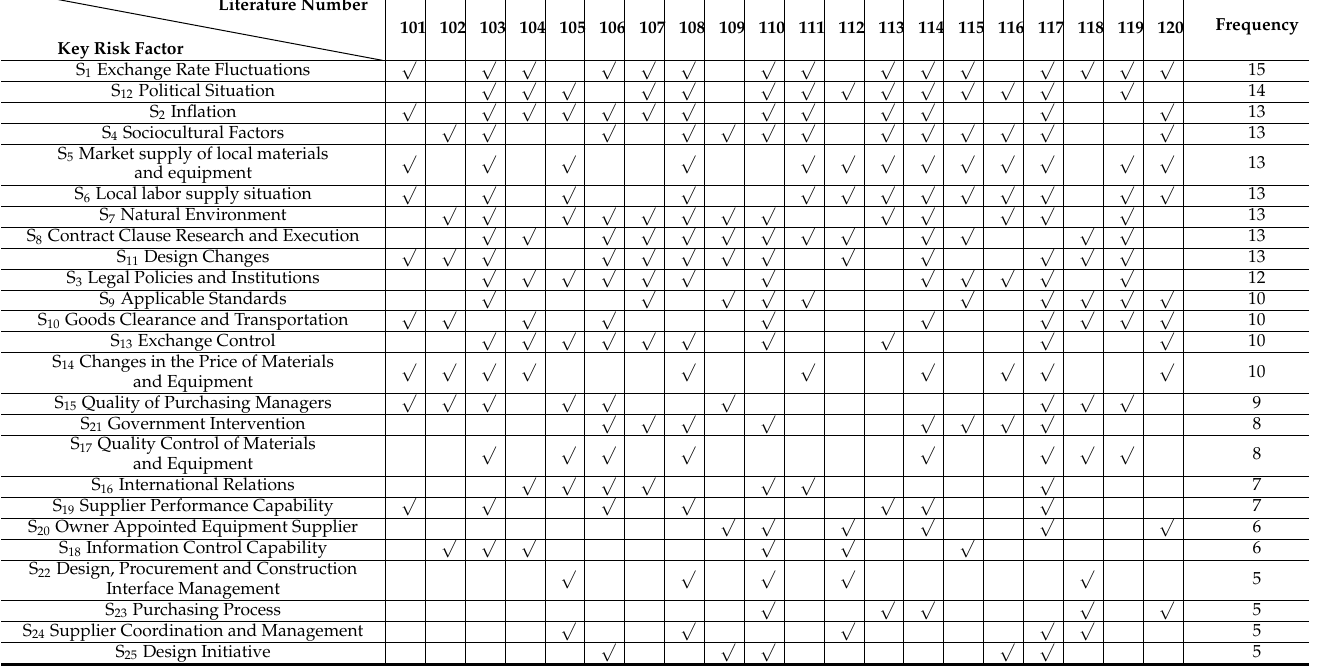
Table 1. List of risk factors.